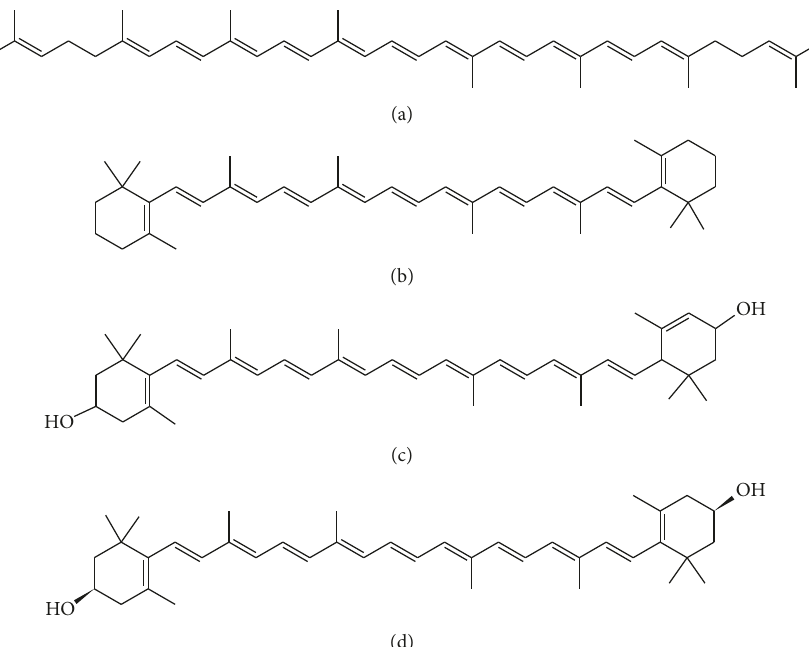
Figure 1: Chemical structure of (a) lycopene (LYC), (b) 𝛽 -carotene (BCAR), (c) lutein (LUT), and (d) zeaxanthin (ZEAX).